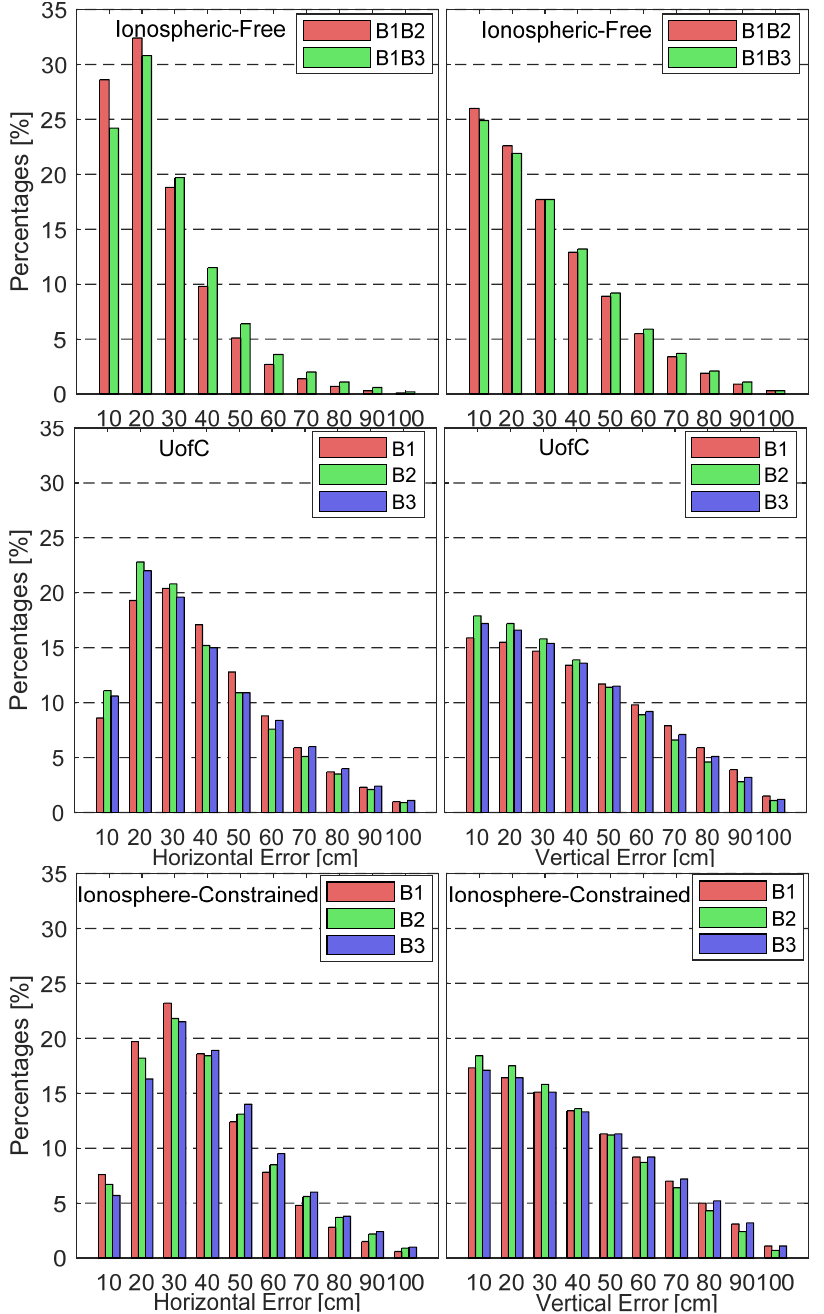
Figure 7. Magnitude distribution of BDS SBAS corrections-based kinematic dual-frequency (DF)- and single-frequency (SF)-PPP positioning errors for different schemes. Each histogram bin represents a range of 10 cm, e.g., 100 means positioning errors within range of [90, 100] cm. Table 5 summarizes the RMS of the horizontal and vertical positioning errors of different PPP calculated based on the coordinates from the first converged epoch to the last epoch of an arc (6 h) and static statistics are based on the coordinates of the last epoch in each solution. For the